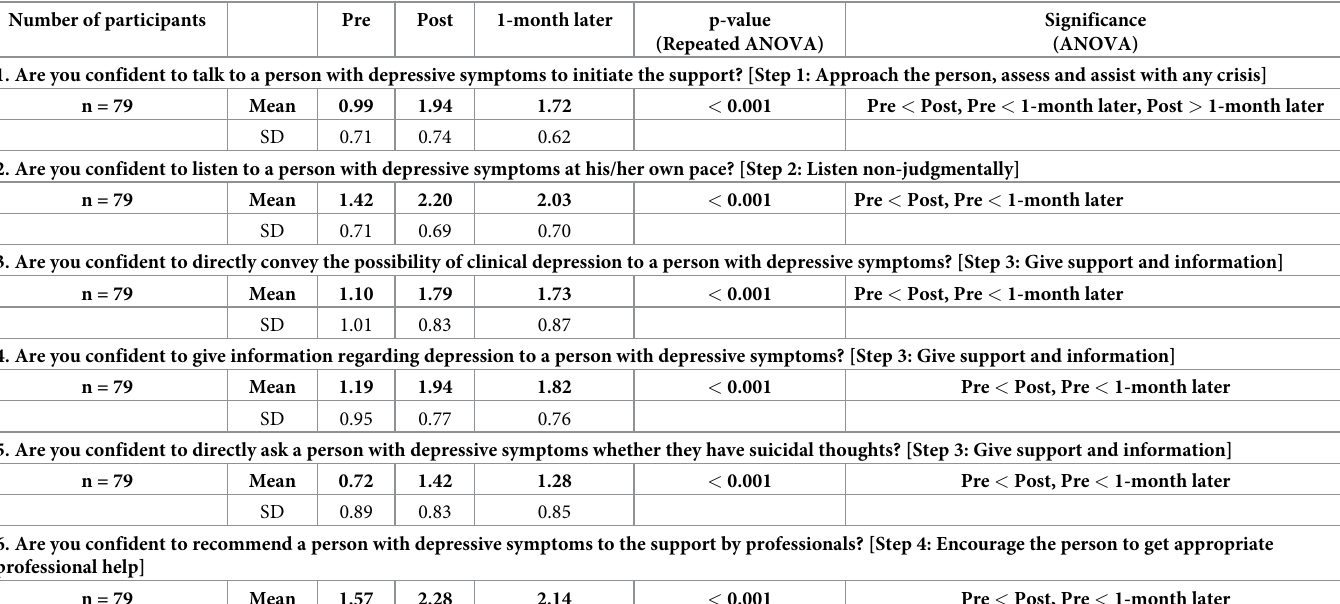
Table 3. Confidence level in management of people with depression and suicidal